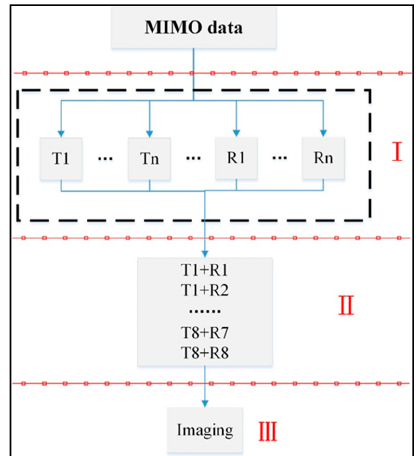
Figure 12. Imaging geometry for through-wall radar (TWR) with the designed MIMO array.